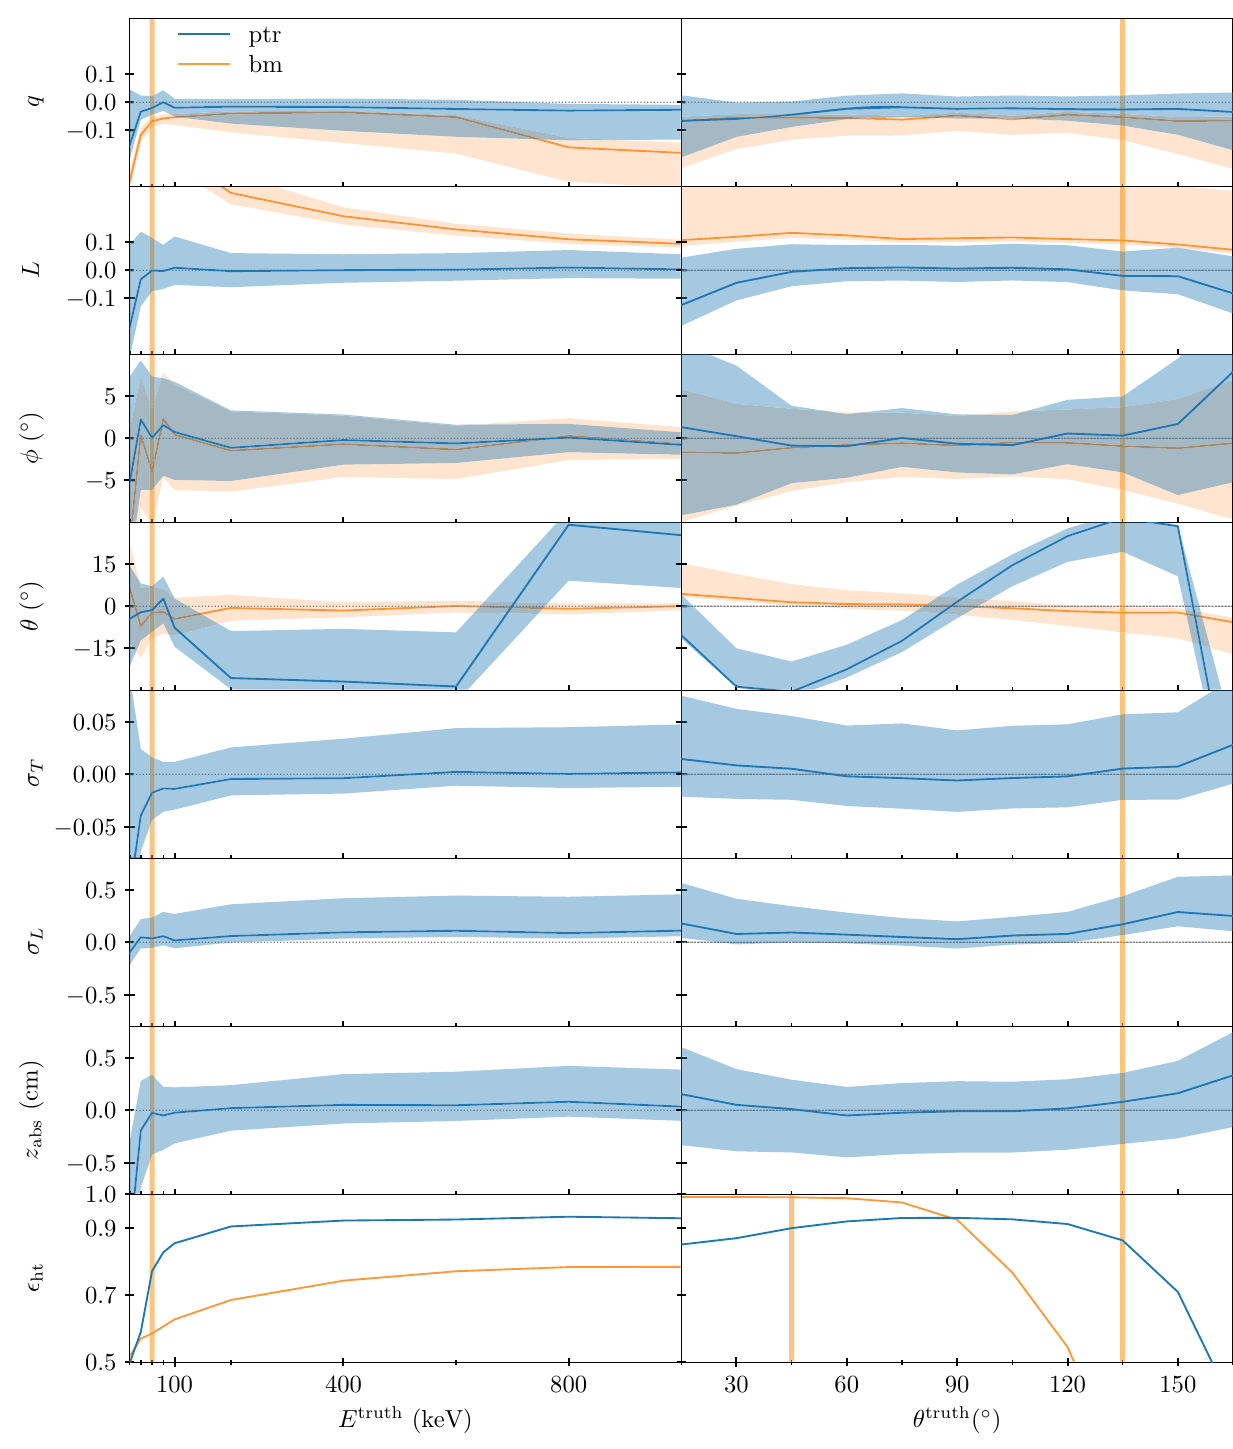
Fig. 7 A summary of the performance of ptr versus the benchmark methods using the simulated dataset. Each row shows the bias (solid lines) and resolution (shaded regions) of the parameter errors versus truth energy E truth and polar angle θ truth . For the angles θ and φ , errors due to head-tail misassignment have been removed. Parameter errors